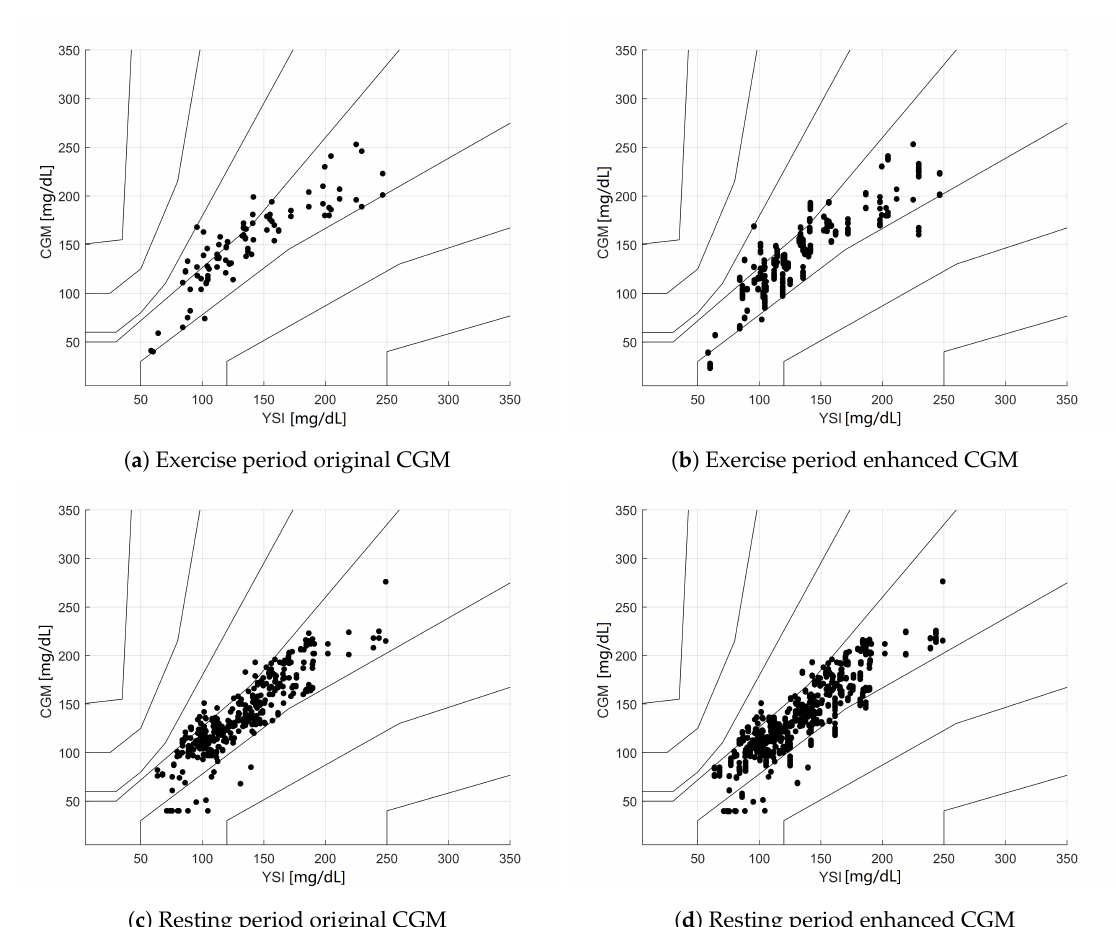
Figure 4. Parkes error grid analysis for the wearable-enhanced CGM estimations. ( a ) Subset of CGM-YSI pairs before enhancement during the physical activity period. ( b ) Subset of CGM-YSI pairs after enhancement with exercise monitoring devices during the physical activity period. ( c ) Subset of CGM-YSI pairs before enhancement during the resting period. ( d ) Subset of CGM-YSI pairs after enhancement with exercise monitoring devices during the resting period.